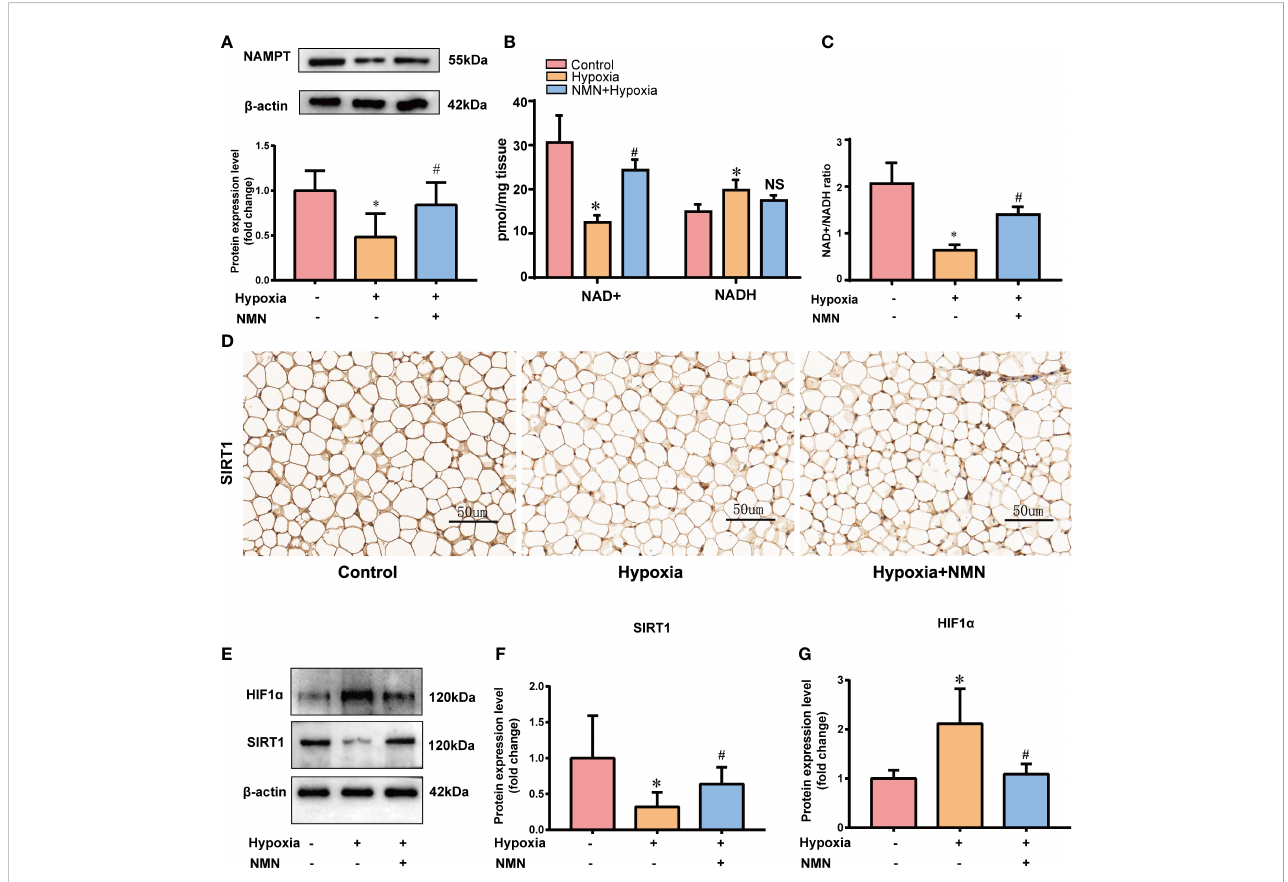
FIGURE 3 NMN restores NAMPT/NAD+/SIRT1 axis and inhibited HIF-1 a acetylation in eWAT of hypoxia induced mice. (A) The relative protein levels of NAMPT normalized to b -actin in eWAT (n = 5). (B, C) Statistical results for NAD + /NADH contents and NAD + /NADH ratio in eWAT (n = 6). (D) Representative images of immunohistochemical staining for the SIRT1 protein in eWAT sections (400× magni fi cation, scale bar=50 m m). (E – G) The relative protein levels of SIRT1 and HIF1 a in eWAT (n = 5). * P < 0.05 versus control group, # P < 0.05 versus hypoxia group. NS indicates no signi fi cant difference compared with the matched